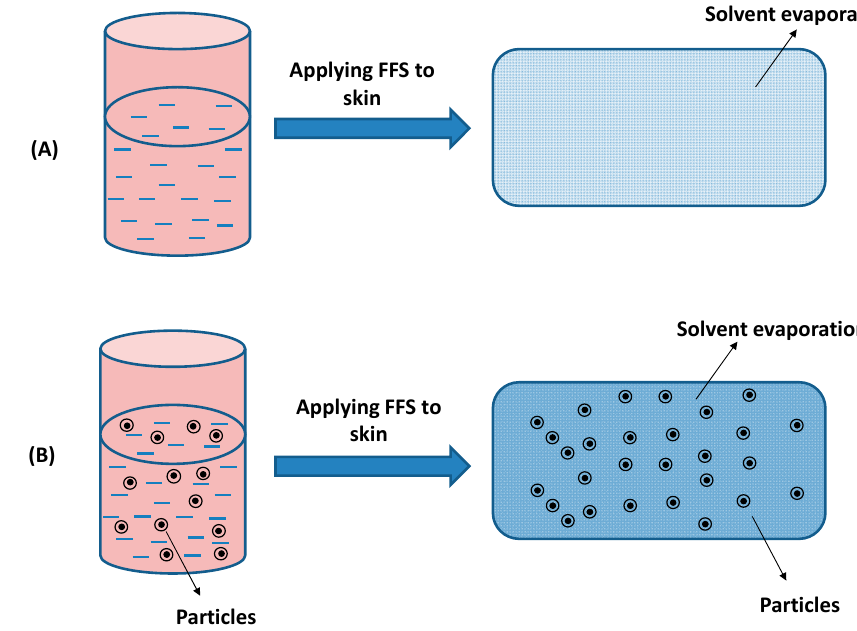
Figure 1. Illustration of film formation of film-forming systems (FFSs) containing solution ( A ) or dispersion of particles ( B ).